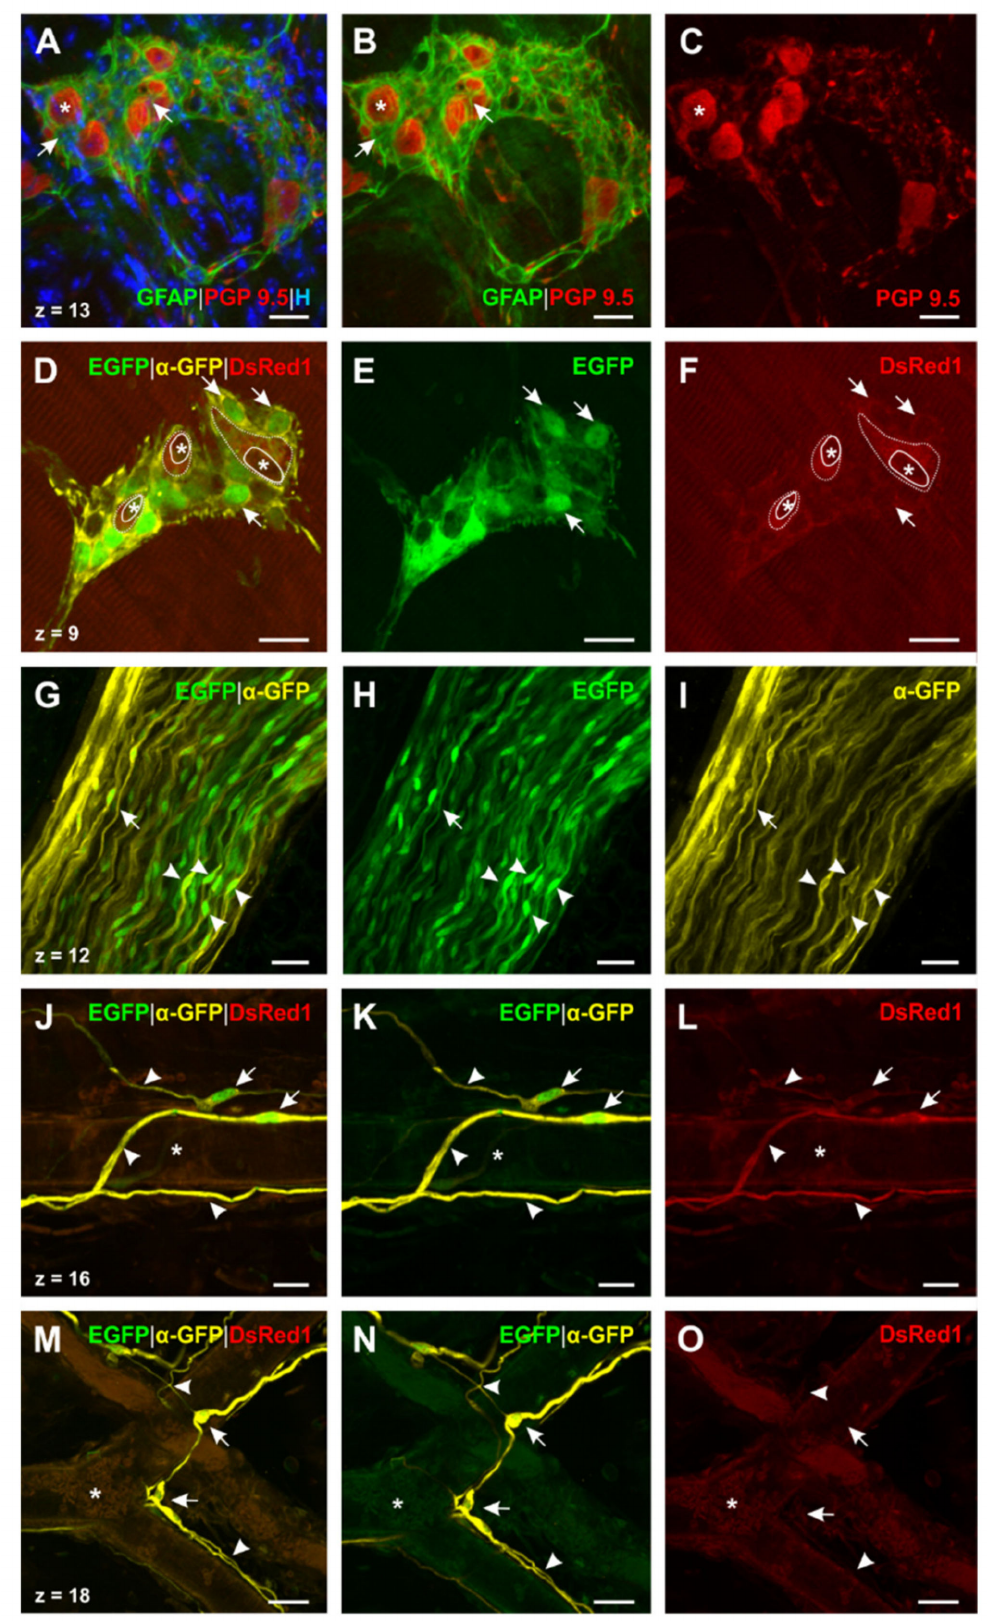
Figure 5. Distribution of PLP and GFAP in esophageal glial cells. ( A – C ): Triple staining for GFAP, PGP 9.5, and Hoechst (N ◦ 3 (cid:13)